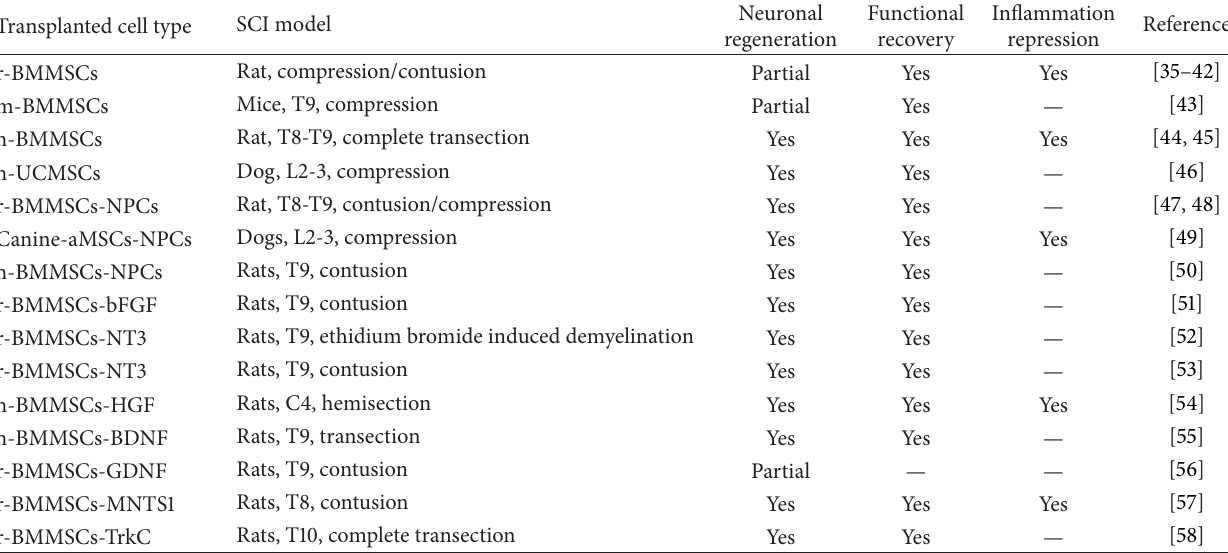
Table 2: Preclinical spinal cord injury trials using mesenchymal stromal cells (MSCs). Transplanted cell